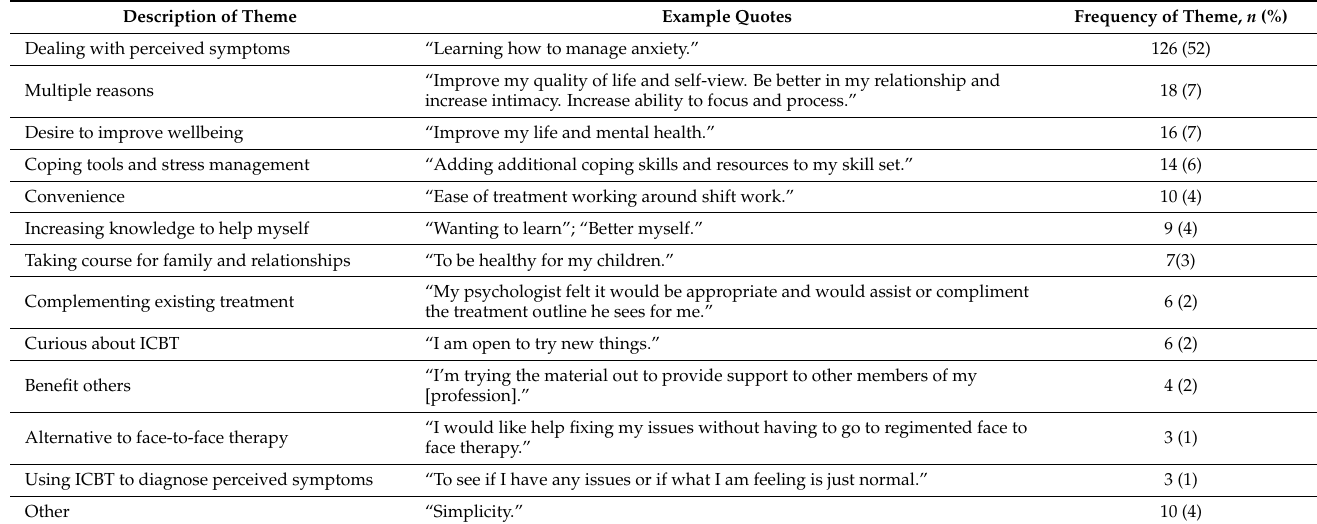
Table 2. Results of thematic analysis of motivations for seeking ICBT.